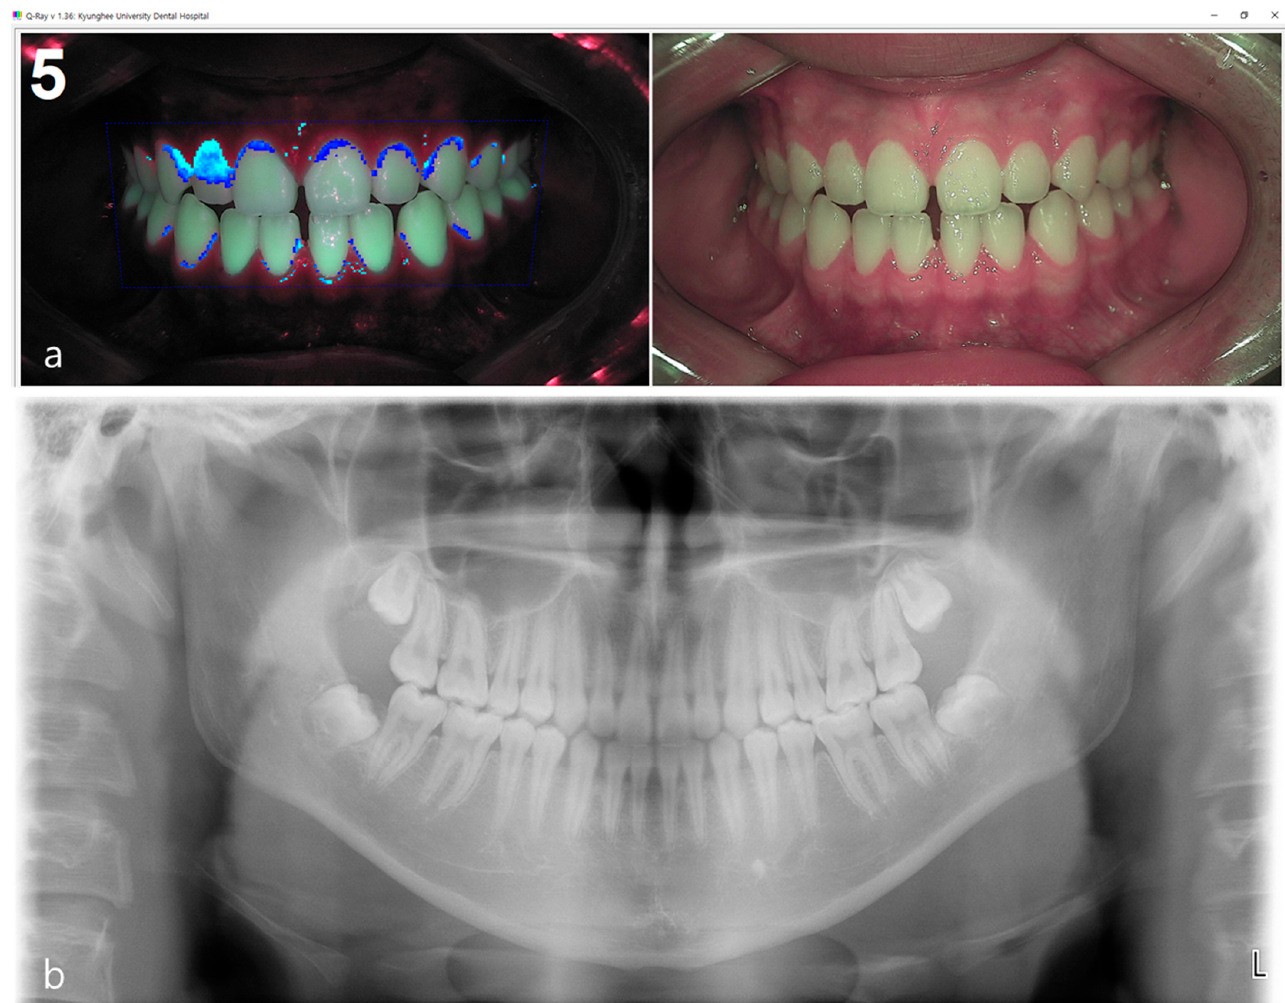
Figure 1. ( a ) Fluorescent plaque index (FPI) score using propriety software of the quantitative light-induced fluorescence (QLF) system was 5 which shows a serious degree of dental plaque pathogenicity, ( b ) while the score of radiographic bone loss (RBL) shown in the panoramic image was 1.1 which was close to normal.